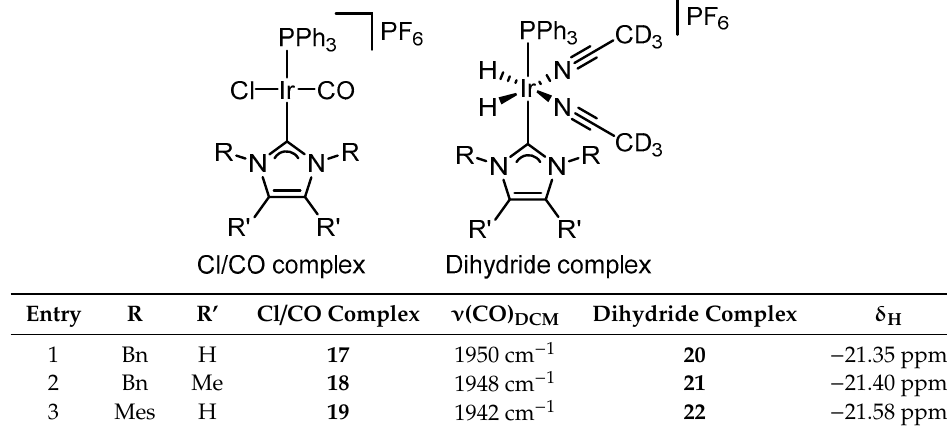
Table 3. Electronic properties of Ir Cl/CO and dihydride complexes.